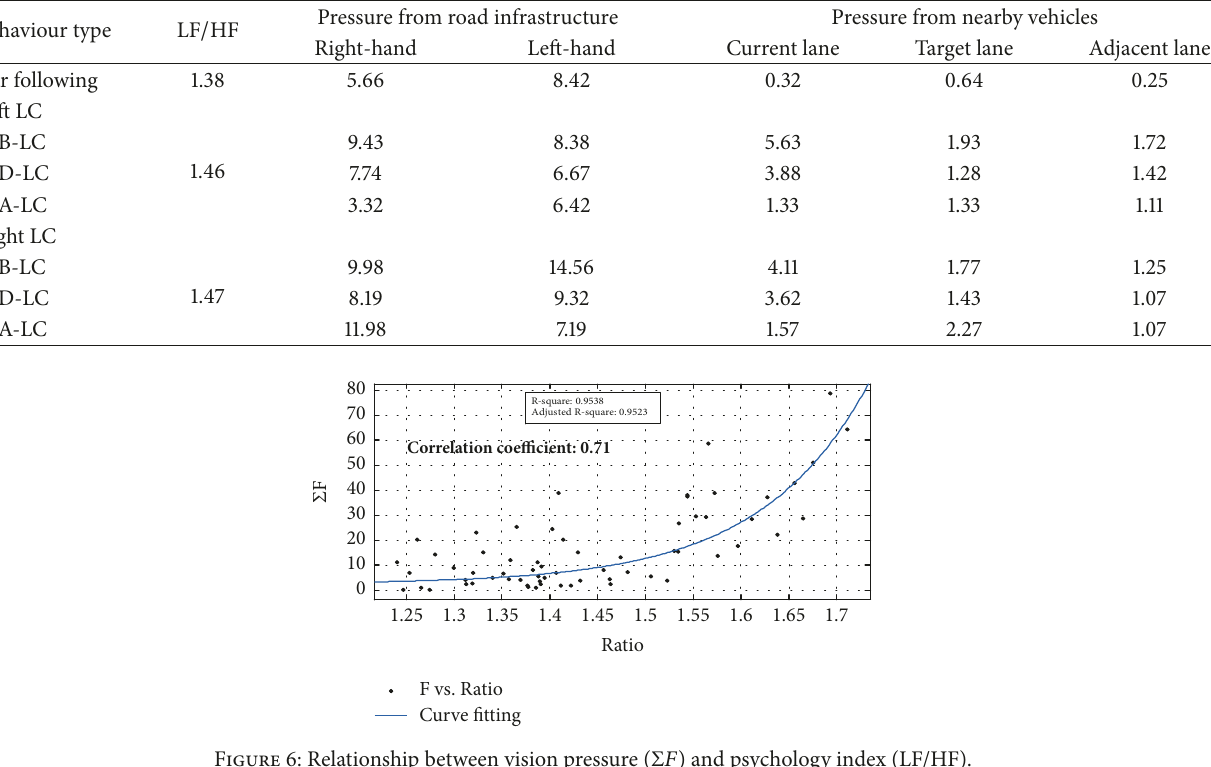
Figure 6: Relationship between vision pressure ( Σ𝐹 ) and psychology index